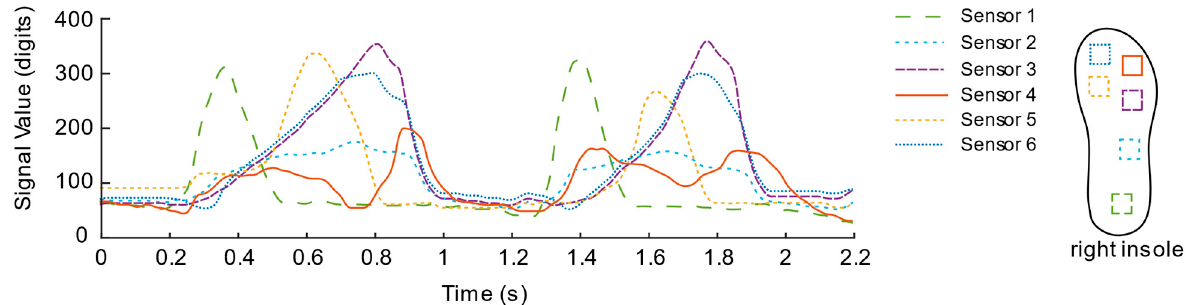
Figure 10. Signal Curve of the first insole solution.